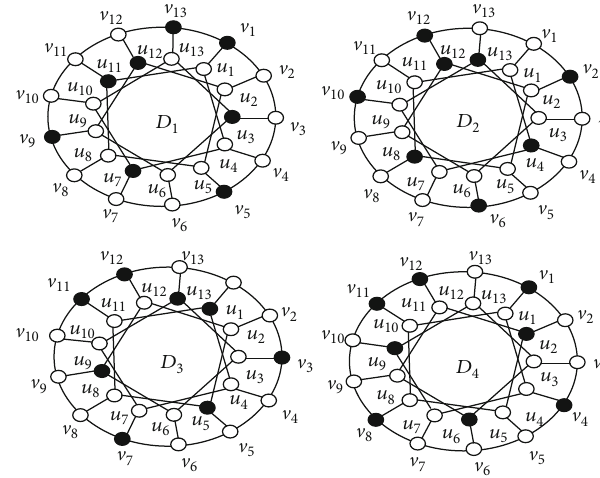
Figure 14: Eternally protecting P ð 13, 3 Þ with 8